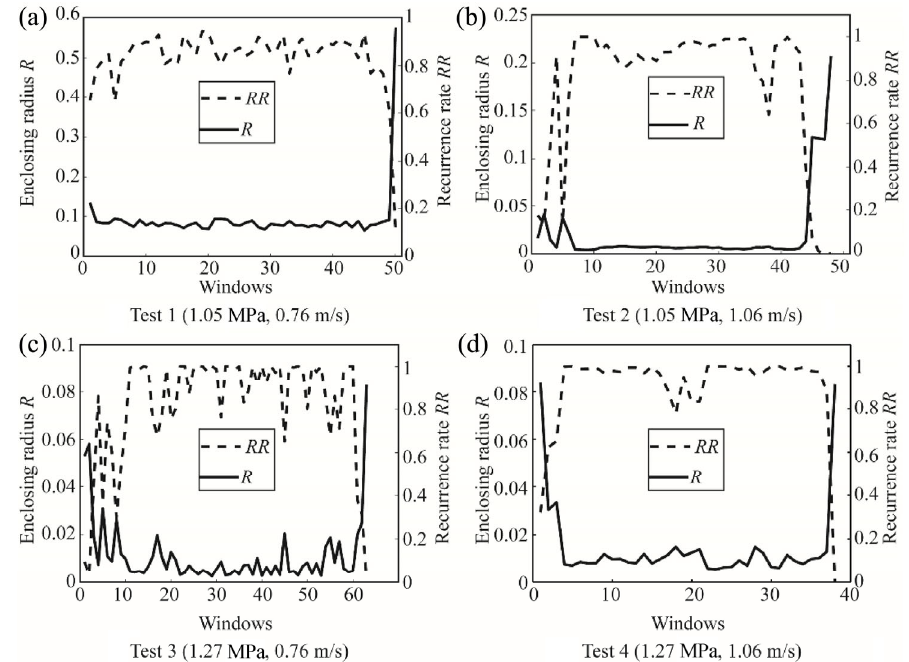
Fig. 8 Evolvement of R and RR of running-in attractors during the friction